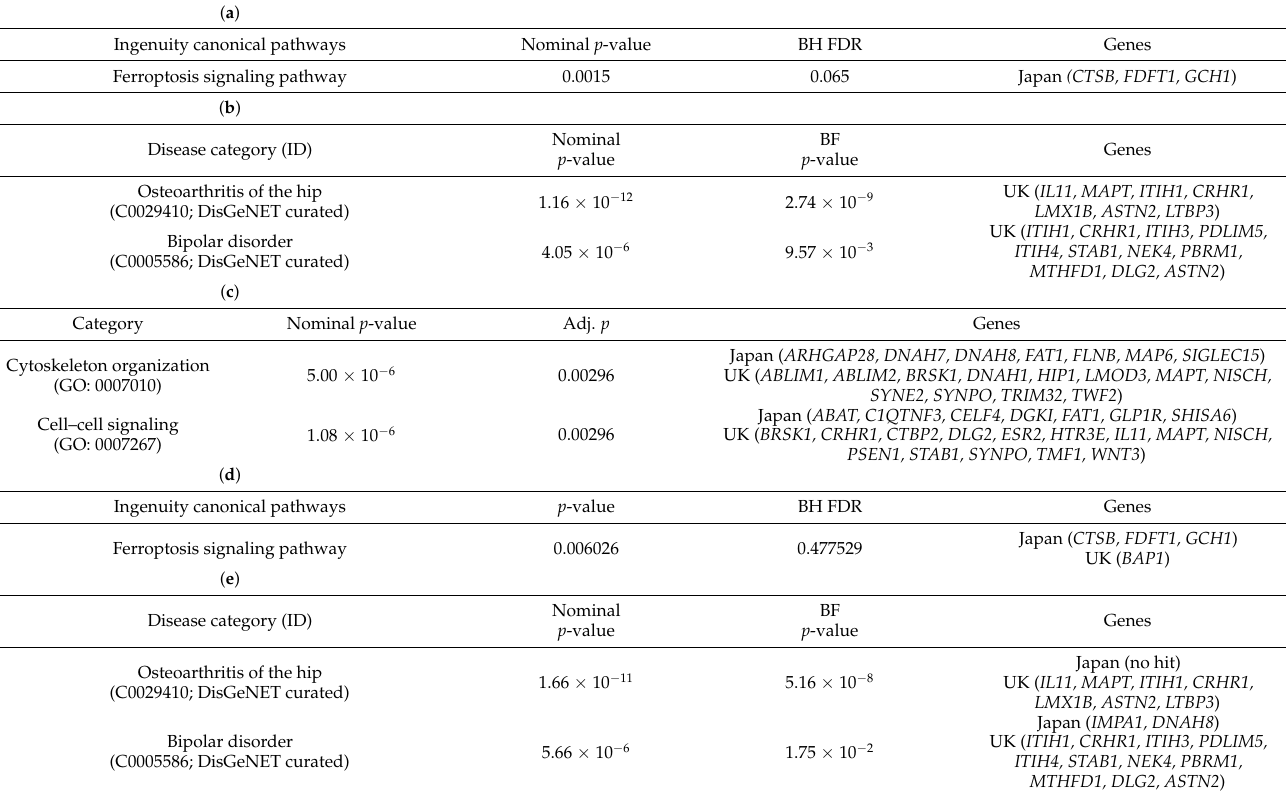
Table 3. ( a ) Pathway enrichment analysis of 42 Japanese GWAS genes using IPA. One pathway is significant (BH FDR < 0.1 and more than three genes in the pathway category). ( b ) Disease-related gene enrichment analysis of 96 UK GWAS genes using ToppGene. Two diseases are significant (BF p -value < 0.01, with more than three genes in the disease category). ( c ) Pathway enrichment analysis to merge 138 genes with FUMA2FUNC. The two categories meet the condition with at least one gene derived from both cohort studies and adj . p < 0.05. ( d ) Pathway enrichment analysis to merge 138 genes with IPA. One pathway meets the condition with at least one gene derived from both cohort studies and a nominal p- value < 0.01. ( e ) Disease-related gene enrichment analysis to merge 138 genes with ToppGene. Two diseases meet the condition, with a BF p -value < 0.05. Only the second-highest hit passes the condition, and at least one gene is derived from both cohort studies. ( c – e ) Enriched genes in the Japanese and UK studies are listed in brackets after Japan and UK, respectively. All gene orders (within parentheses) are